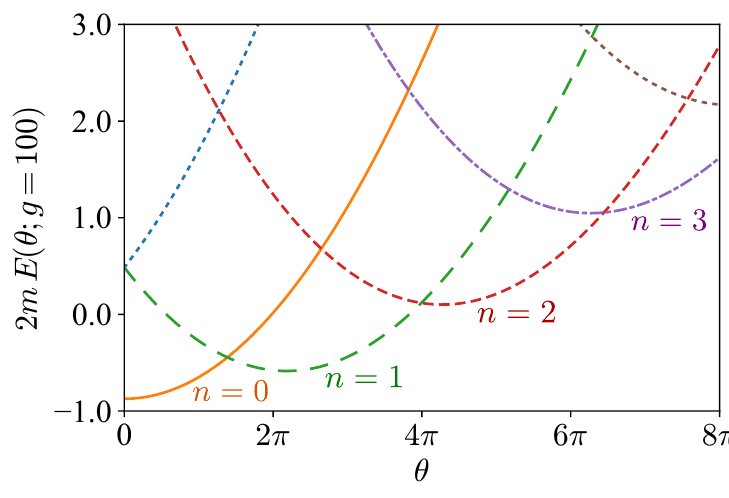
Figure 3 . Eigenenergies E n ( θ ; g ) at g = 100 for various n as functions of θ . The energy is shifted p by an offset of − g/ 2 ’ − 7 . 1